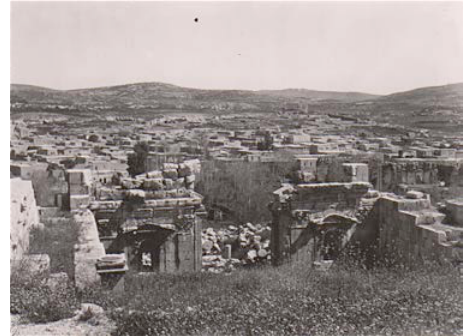
Fig. 4: A detail from a contact print in the Horsfield archive showing a view through the Propylea of Artemis with Jerash vil- lage beyond. (Copyright UCL Institute of Archaeology).